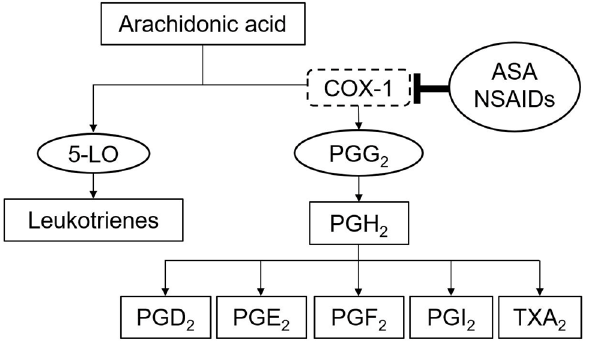
Figure 1. Mechanism of cyclooxygenase 1 (COX-1) inhibition by acetylsalicylic acid (ASA) or nonsteroidal anti-inflammatory drug (NSAID). 5-LO—5-lipoxygenase, PG—prostaglandin (types G 2 , H 2 , D 2 , E 2 , I 2 and F 2 ), TxA 2 —thromboxane A 2 .